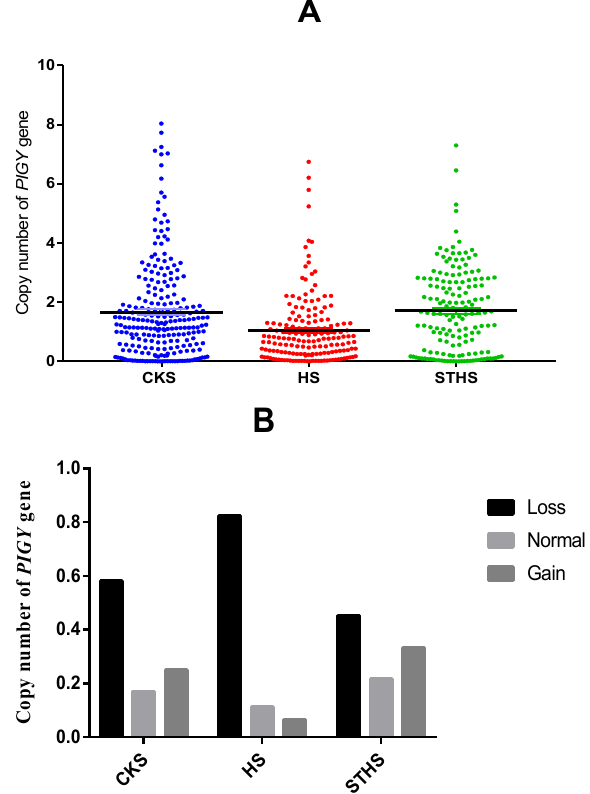
Figure 5. ( A ) Distribution of the PIGY gene's CNV in three sheep breeds. ( B ) Frequency of the copy numbers of the PIGY gene’s CNV in three sheep breeds. CK: Chaka sheep, HS: Hu sheep, STHS: small-tailed Han sheep.